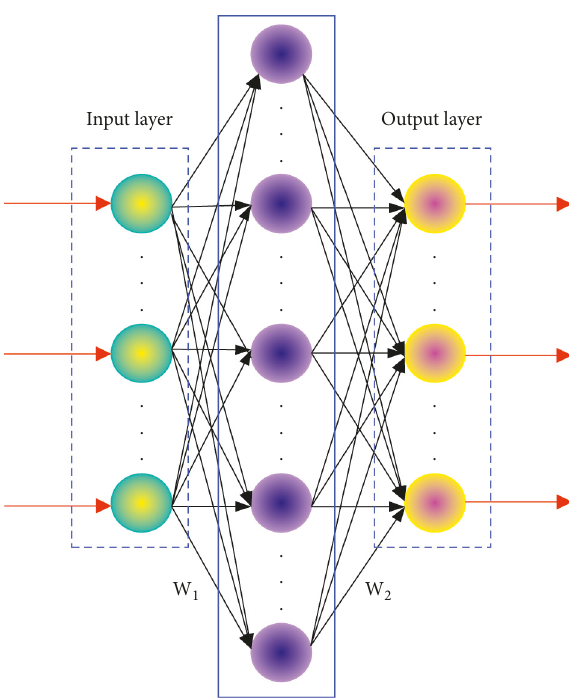
Figure 1: Connections between neurons in different